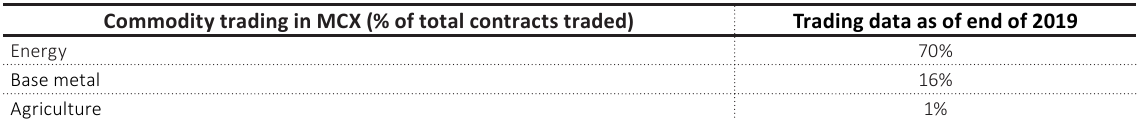
Table 1. Percentage of total contracts of commodity futures traded on